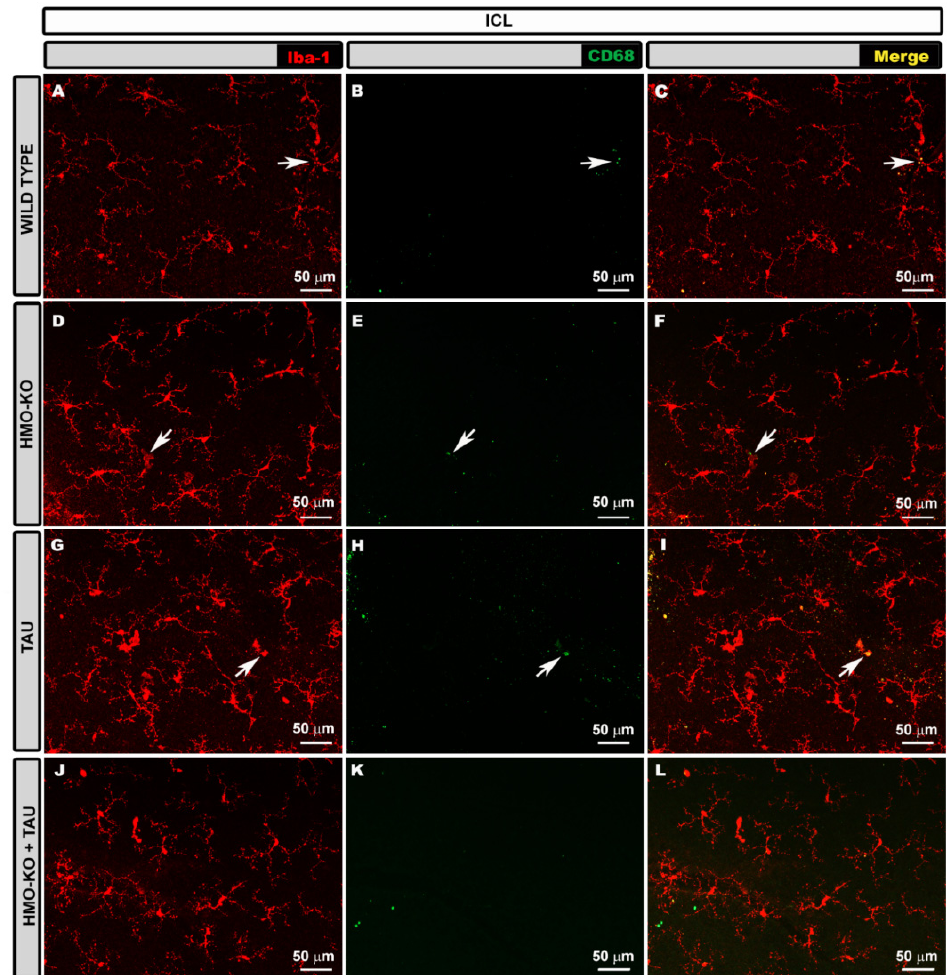
Figure 4. Retinal wholemount. Double immunostaining with anti-Iba-1 (red) and anti-CD68 (green) in ICL in the different study groups: WT ( A – C ), HMO-KO ( D – F ), TAU ( G – I ), HMO-KO+TAU ( J – L ); 20 × magnification. Arrows indicate microglial cells with CD68+ labelling. Number of retinas used in the experiment: WT n = 6, HMO-KO n = 6, TAU n = 6, and HMO-KO+TAU n =